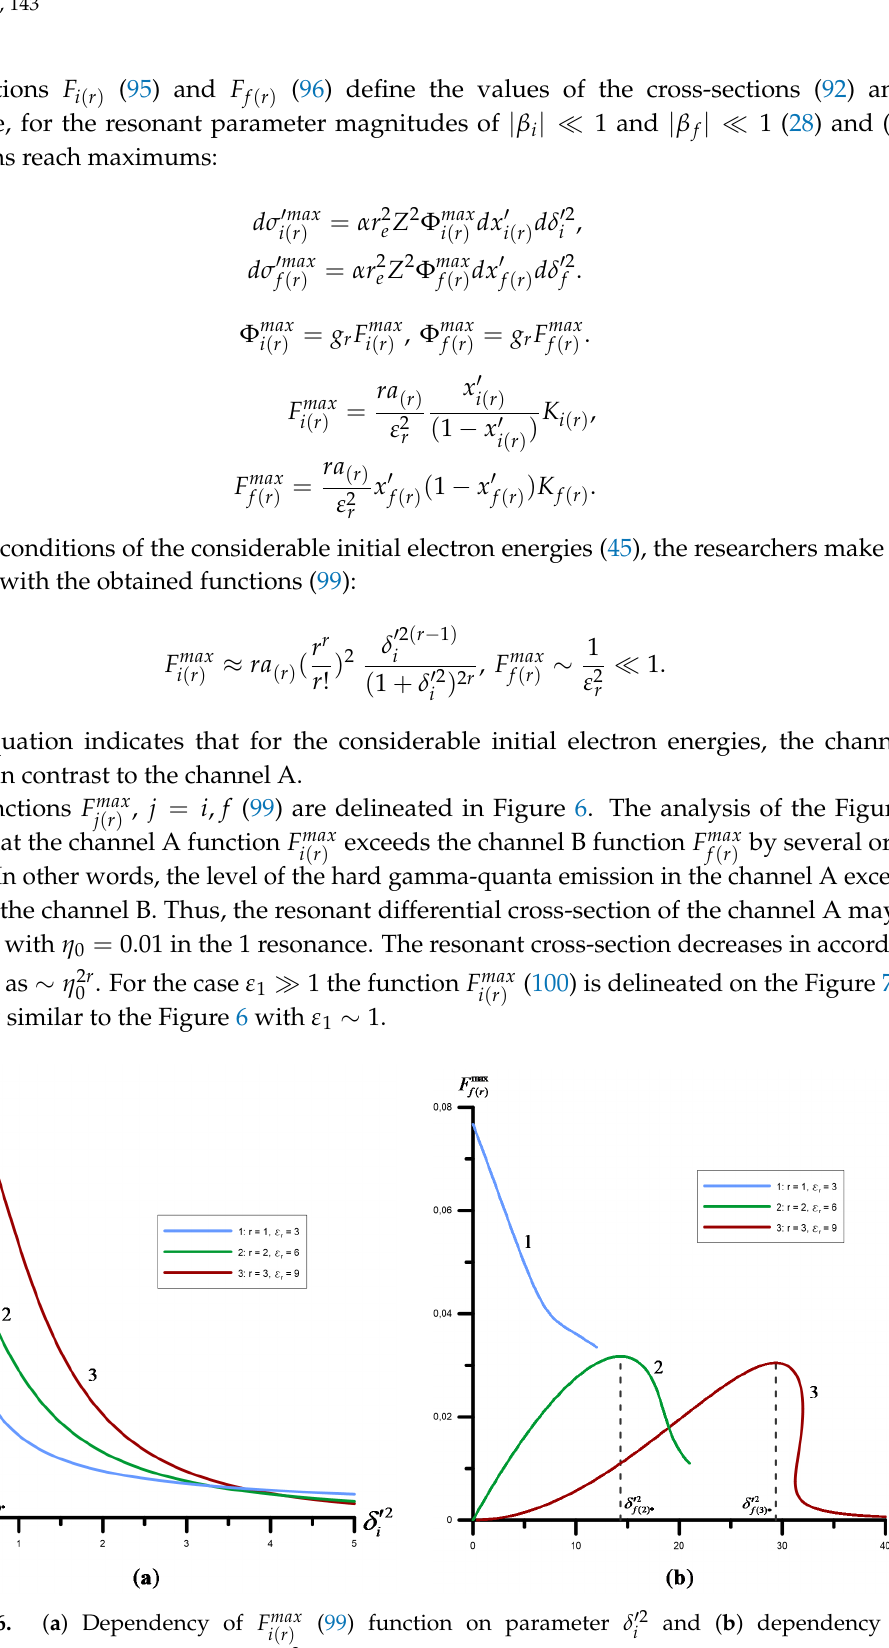
and ( b ) dependency of i